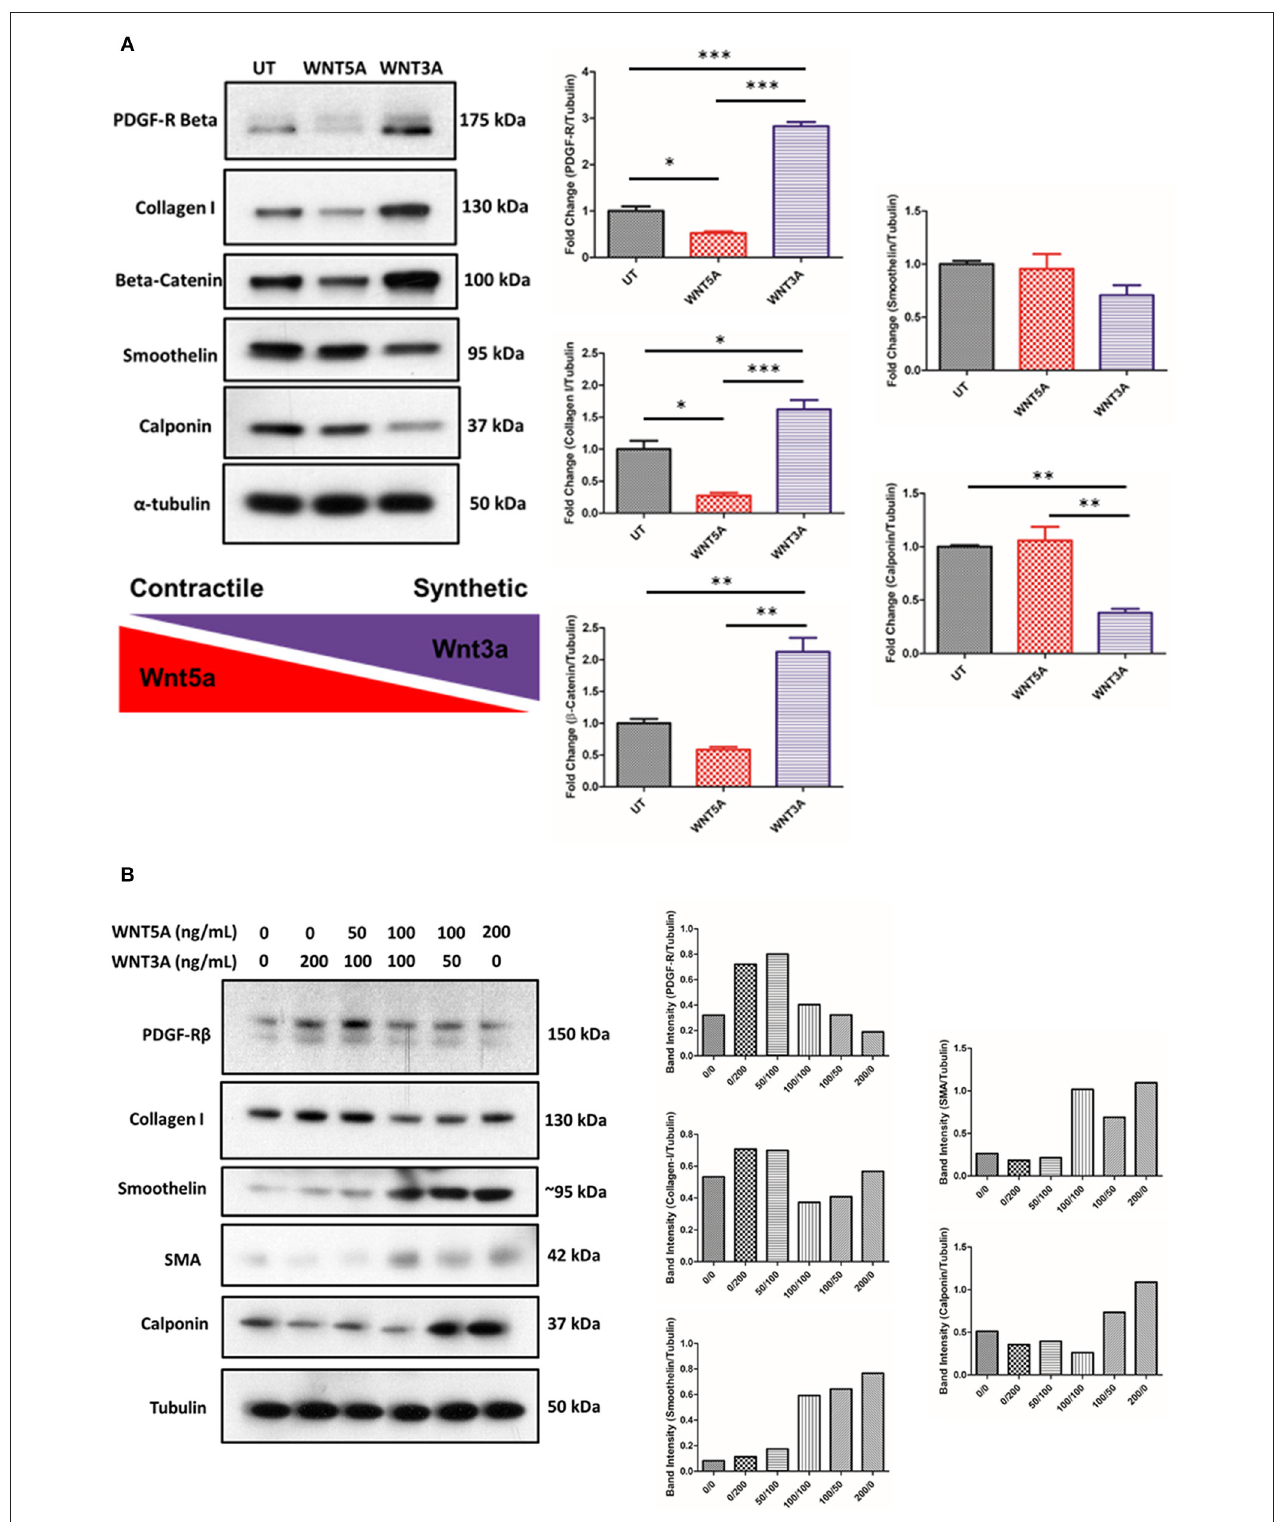
FIGURE 7 | rWNT5A and rWNT3A Regulate VSMC Phenotypic Switching. Representative western blots evaluating the expression of markers of synthetic or contractile VSMCs. VSMCs were incubated in rWNT5A or rWNT3A supplemented medium (both 100ng/mL) for 24h. (A) rWNT3A increased expression of PDGF-receptor-beta, collagen I, and β -catenin. rWNT3A decreased markers of contractile phenotypic differentiation (calponin, smoothelin). rWNT5A did not